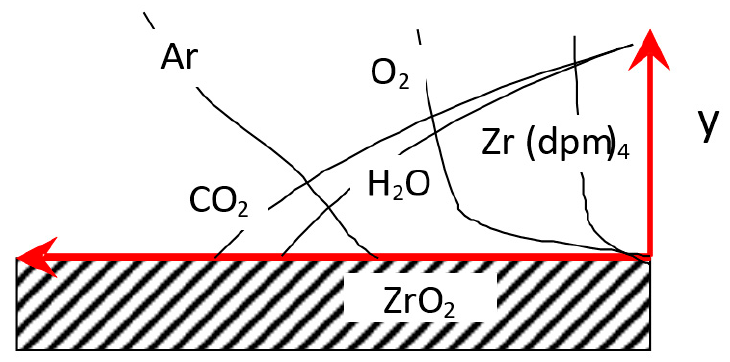
Figure 1. Flow diagram.